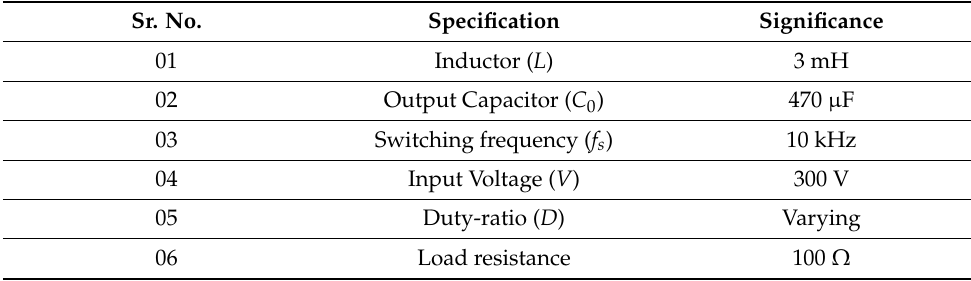
Table 4. Specifications of Buck